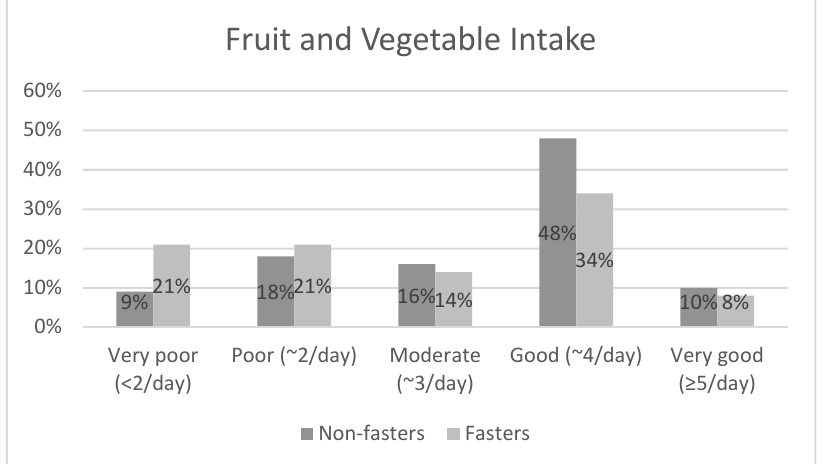
Figure 2. Bar chart for fruit and vegetable consumption between fasters and non-fasters. Pearson’s Chi square of independence test was carried out to determine the relation- ship between fruit and vegetable consumption and fasting status. As seen in Table 3, there was a significant association between fasting status and fruit and vegetables consumption, with fasters more likely to consume fruit and vegetables than non-fasters ( p = 0.009). Table 3. Fruit and vegetable